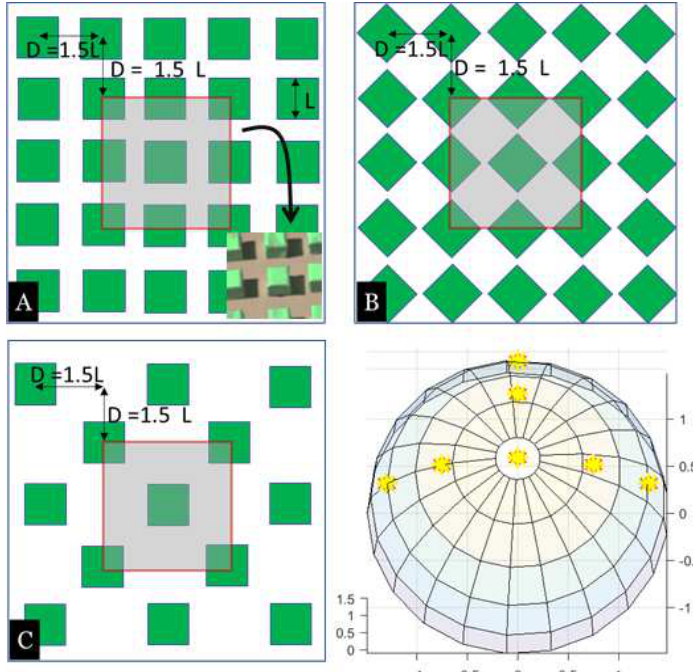
Figure 1. An illustration of the imaging configuration (righ bottom corner); the camera positions are marked on top of the hemisphere. Tiles A, B, and C show the repetitive patterns A, B, and C, respectively; the imaged area is marked with a square. This area is aggregated into a single pixel to create a spectral mixture. One of the real seven images for pattern A is shown in the right bottom corner of its corresponding tile.